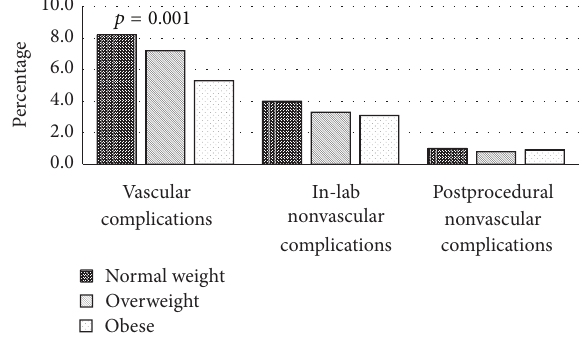
Figure2:Prevalenceofvascularandnonvascularcomplications(in- lab and postprocedural) by body mass index